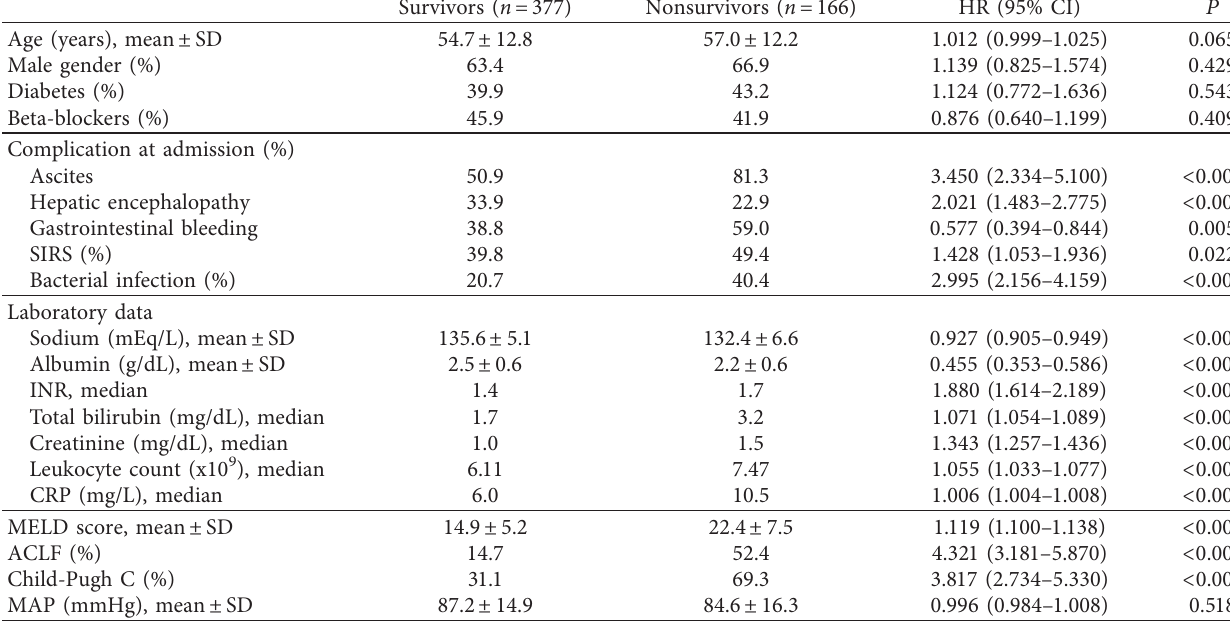
Table 2: Comparison of demographic, clinical, and laboratory data according to 90-day